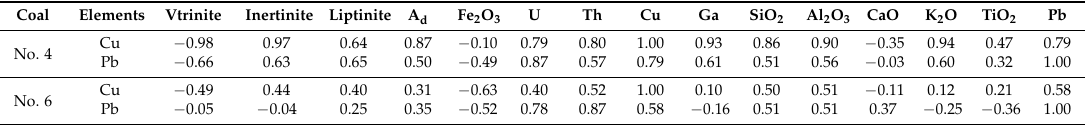
Table 3. The correlation coefficient between Cu, Pb, and some geochemistry parameters in coal. Coal Elements Vtrinite Inertinite Liptinite A d Fe 2 O 3 U Th